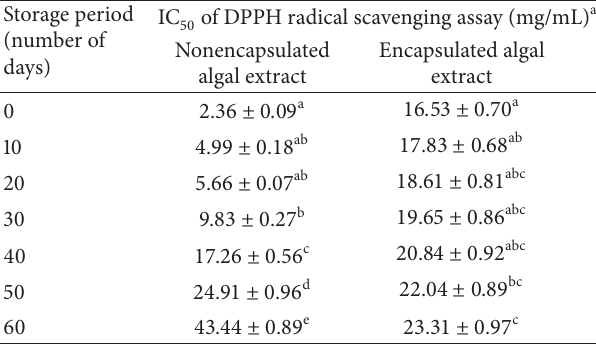
Table 2: Comparative analysis of antioxidant activity of encapsu- lated and nonencapsulated algal extract during storage period of 60 days.